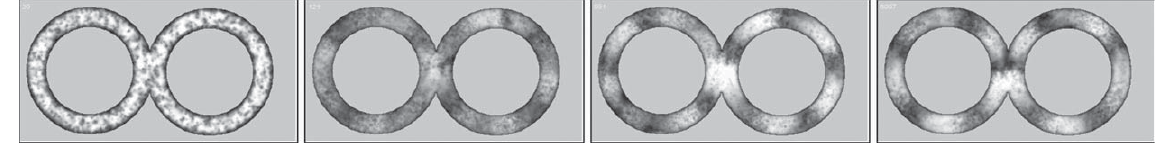
Fig. 17. Emergence of gear-like coupling in an overlapping two rotor pattern. Snapshots taken at 20, 121, 981 and 6997 scheduler steps.